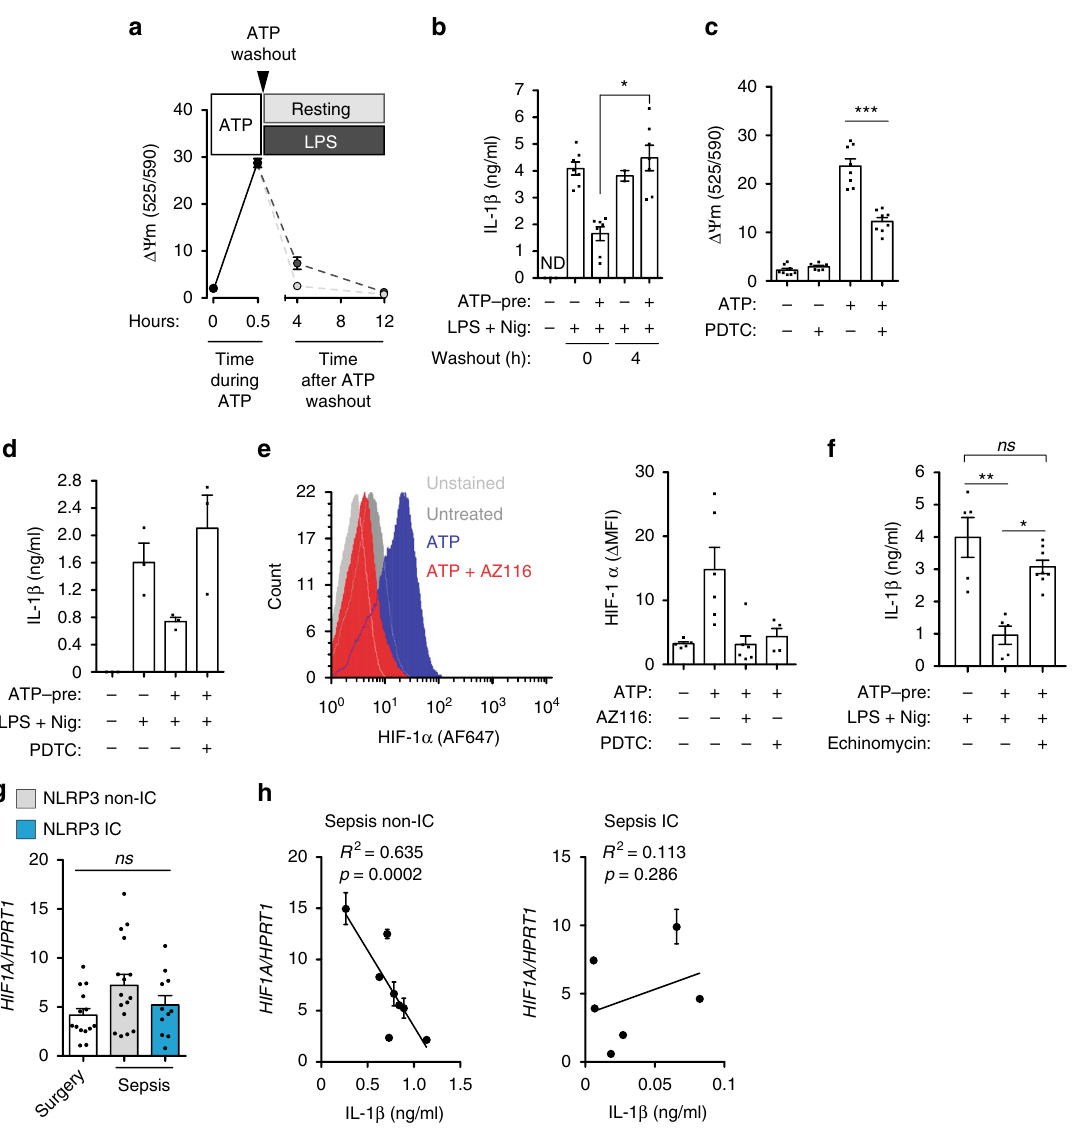
Fig. 7 Mitochondrial dysfunction mediates P2X7 receptor-induced NLRP3 in fl ammasome impairment. a Mitochondrial membrane depolarization in BMDMs treated with ATP (3 mM, 30 min), then washed-out and incubated for the indicated times with or without LPS (1 μ g/ml). b IL-1 β release from wild- type BMDMs treated as in a , but after LPS priming cells were stimulated with nigericin (10 μ M, 30 min). c Mitochondrial membrane depolarization in BMDMs treated with ATP (3 mM, 30 min) in the presence or absence pyrrolidine dithiocarbamate (PDTC, 40 μ M). d IL-1 β release from PBMC isolated from healthy donor blood samples treated with ATP (1 mM, 30 min; ATP-pre) with or without PDTC (10 μ M), then washed and primed with or without LPS (1 μ g/ml, 4 h) and then stimulated with nigericin (10 μ M, 30 min). e Representative histogram plot of HIF-1 α staining (left) or quanti fi cation of mean intensity fl uorescence increase ( Δ MFI, right) in monocytes from healthy donor blood samples treated or not with ATP (1 mM, 30 min) in the presence or absence of AZ11645373 (10 μ M) or PDTC (10 μ M), and then washed and cultured for 2 h; non-stained monocytes (light gray, left). f IL-1 β release from BMDM supernatants treated with ATP (3 mM, 30 min; ATP-pre) in the presence or absence of echinomycin (5 nM), then washed and primed with or without LPS (1 μ g/ml, 4 h) and then stimulated with nigericin (10 μ M, 30 min). g Expression of HIF1A analyzed by qPCR from control surgery group and septic patients PBMCs; septic patients are separated into NLRP3 non-immunocompromised (gray bar) and immunocompromised (blue bar). h Correlation between HIF1A expression and IL-1 β released from septic patients PBMCs treated with LPS (1 μ g/ml, 2 h) and ATP (3 mM, 30 min); IC: immunocompromised septic patients. Each dot represents a single independent experiment or a sample from an individual healthy donor or septic patient; average ± standard error is represented in panels a – g ; exact n number for each panel is presented in Source Data fi le; * p < 0.05; ** p < 0.01; *** p < 0.001; ns , no signi fi cant difference ( p > 0.05); Kruskal – Wallis test was used for b , c , f ; Pearson correlation was used in